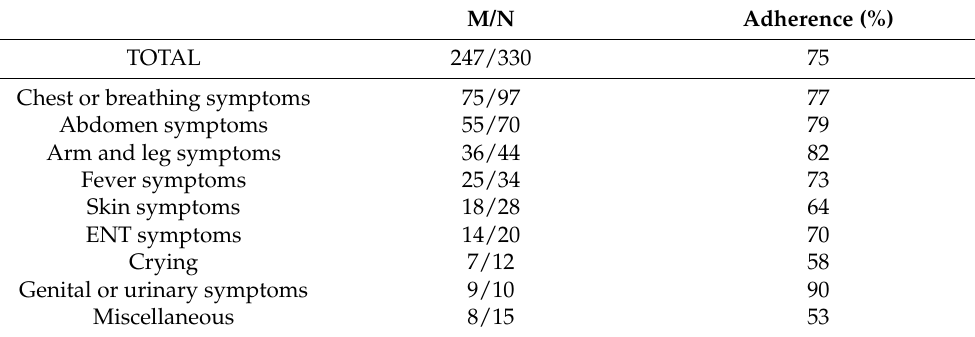
Table 2. Adherence rates overall and by category of complaint.